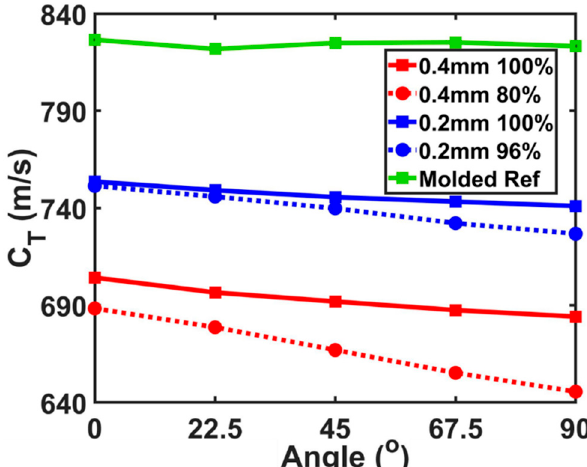
Figure 5. Angle-dependent speed of shear wave measured at 0 ◦ , 22.5 ◦ , 45 ◦ , 67.5 ◦ , and 90 ◦ . Green line represents the results from the reference block. Blue solid (dot) line is the measurement on the sample 2 at 100% (96%) flow rate printed region. Red solid (dot) line is the measurement on the sample 1 at 100% (80%) flow rate printed